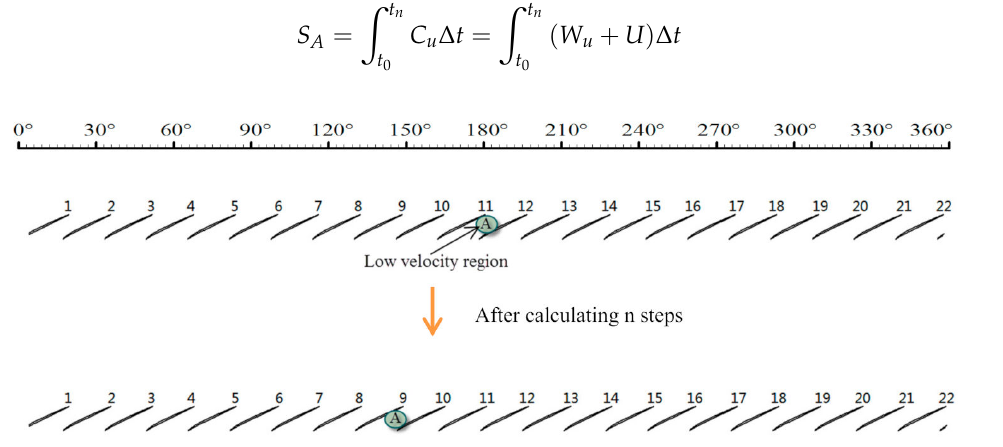
Figure 21. Changes in the computational domain of the rotor under steady